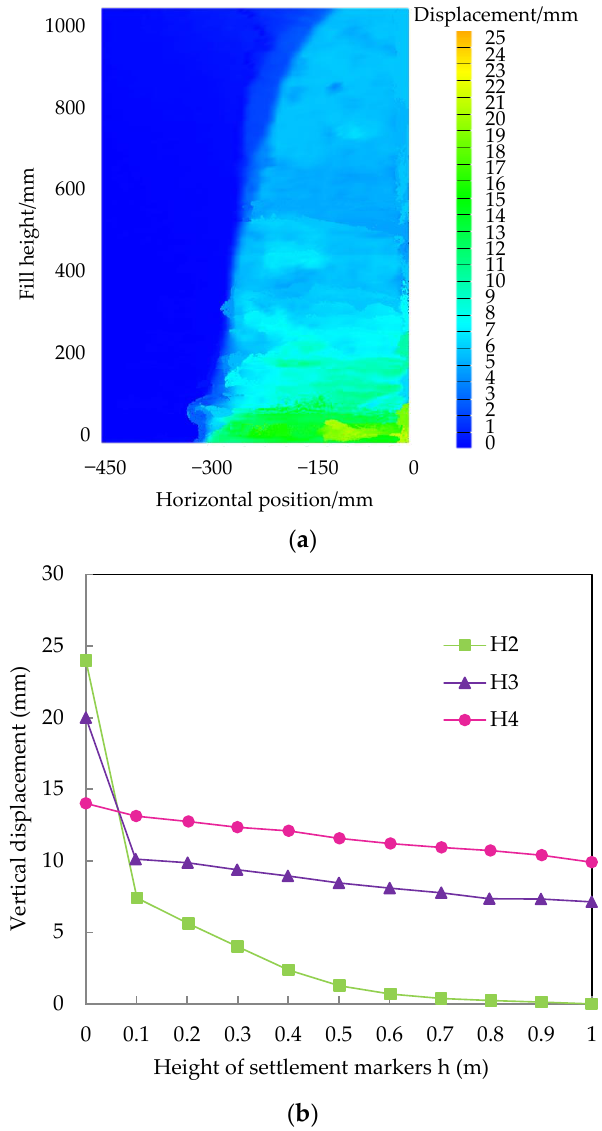
Figure 8. Effect of the subsidence width on the soil displacement: ( a ) vertical displacement cloud image of the soil; ( b ) vertical displacement curves with different soil heights.